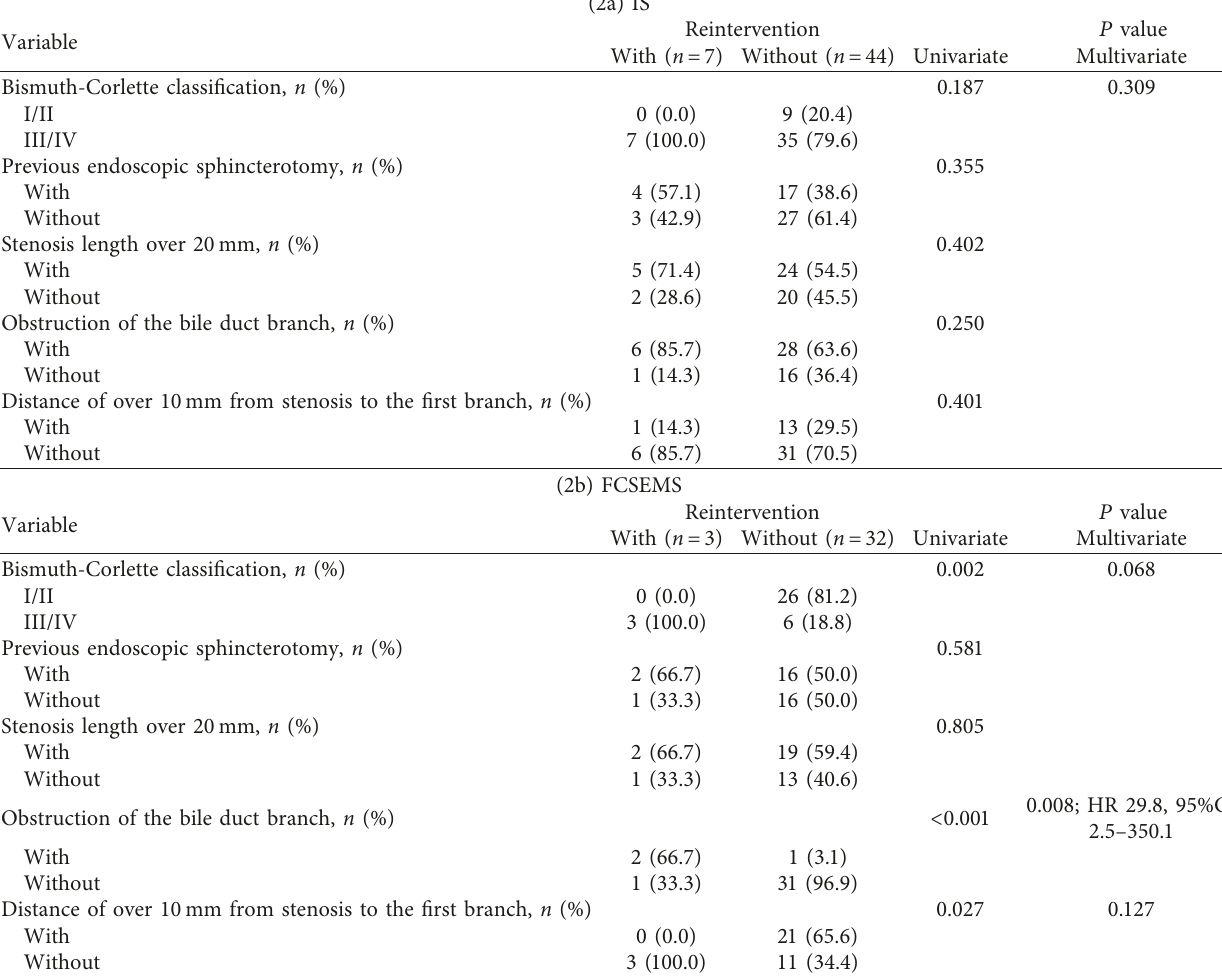
Table 2: Univariable and multivariable analyses of